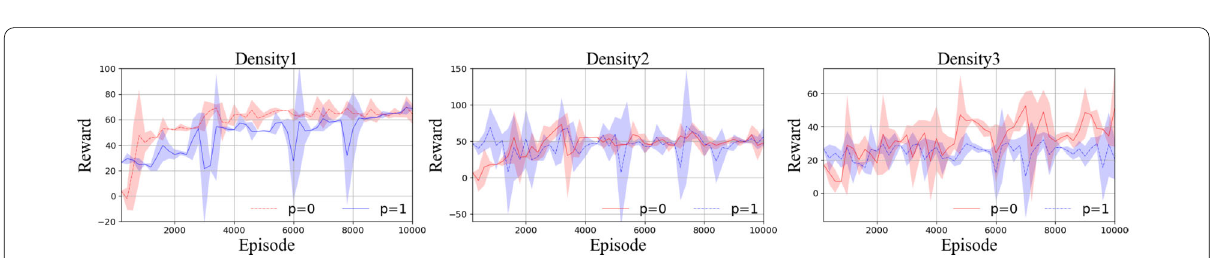
Figure 6 Performance comparisons on different politeness coefficients p under different traffic